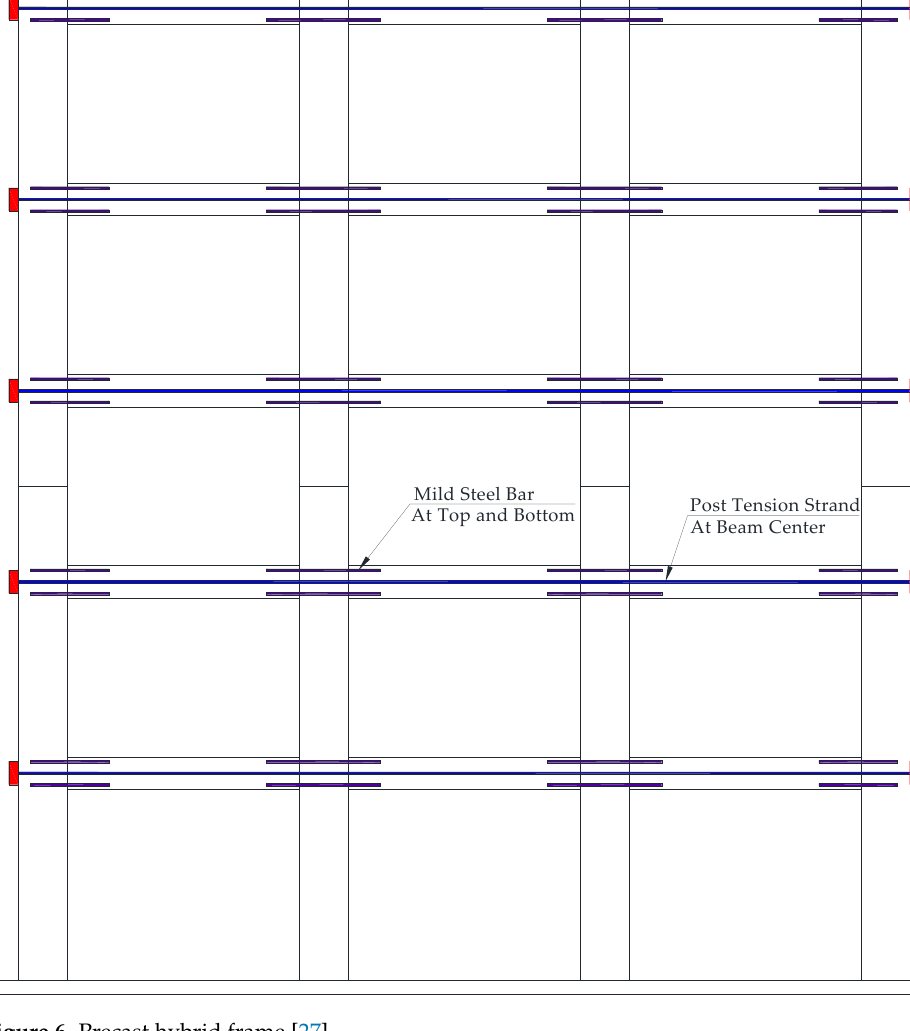
Figure 6. Precast hybrid frame [27].